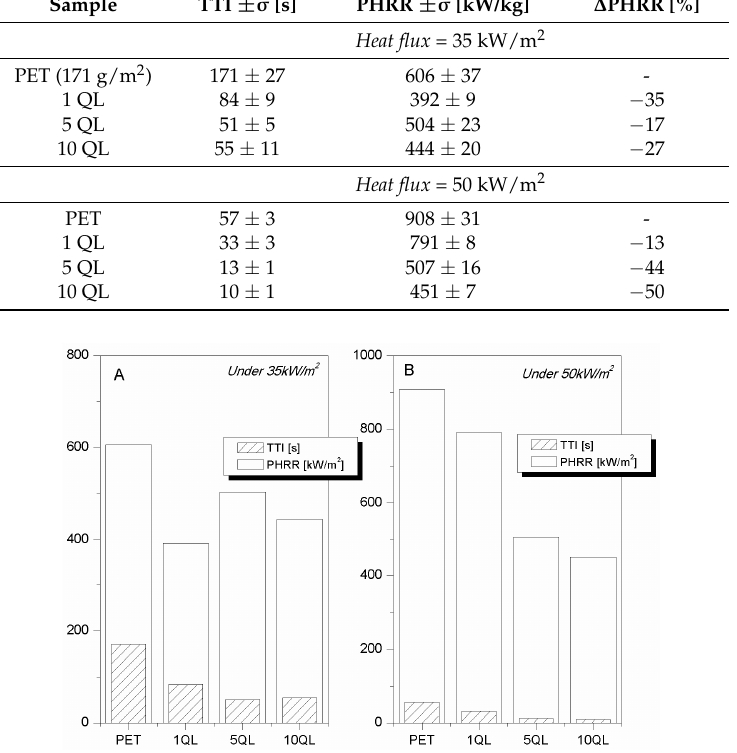
Figure 11. TTI and PHRR values of PET fabrics treated with 1, 5 and 10 QL of char-former assemblies at 35 and 50 kW/m 2 ( A , B , respectively) [29].